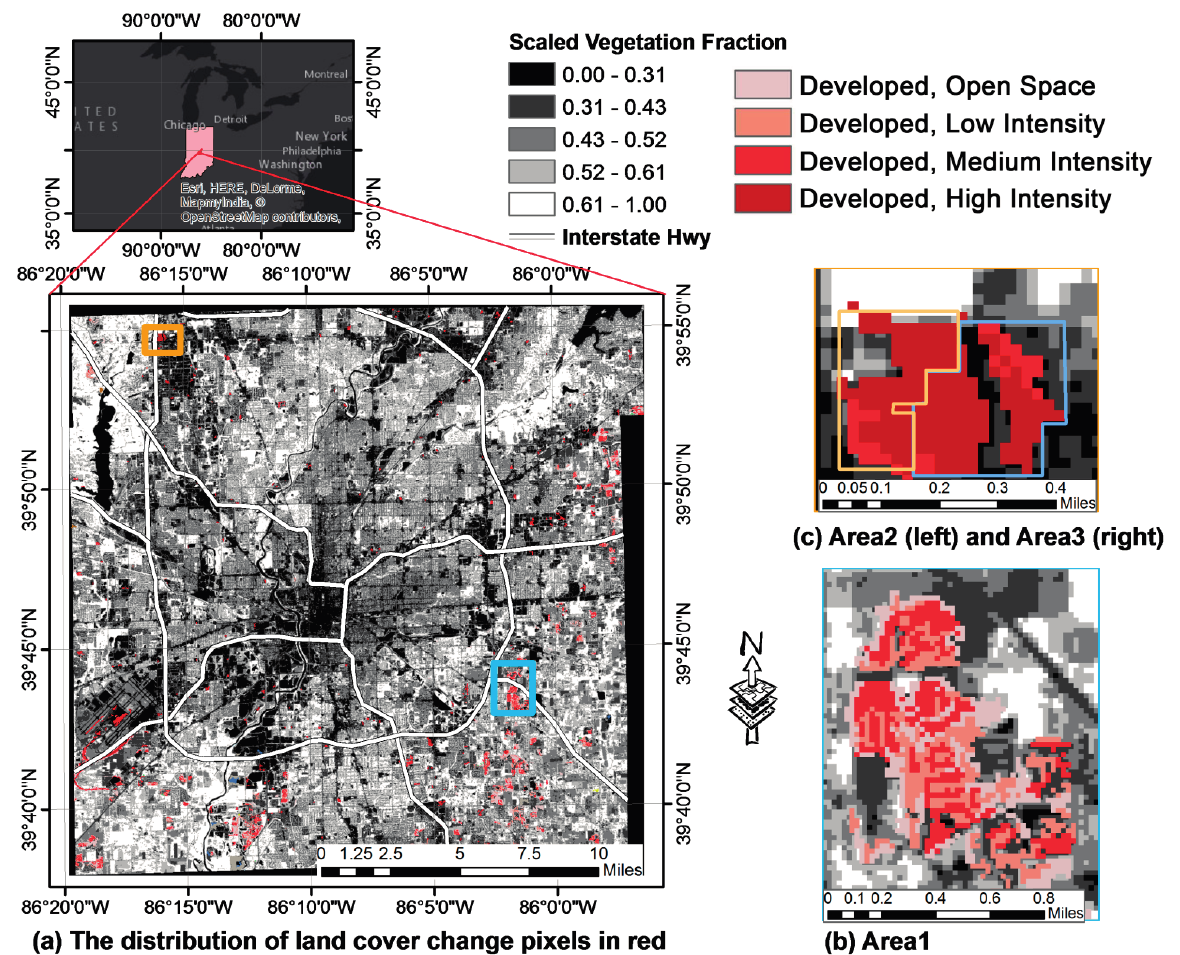
Figure 1. Three sample areas for assessing the impact of urbanization in the City of Indianapolis, USA. The vegetation fraction was produced by the Landsat TM image that acquired on 16 June 2001. ( a ) The whole study area, ( b ) Area 1 is characterized by conversions from cultivated to residential lands, ( c ) Area 2 and Area 3 represent changes from forest to commercial, and from open area to commercial